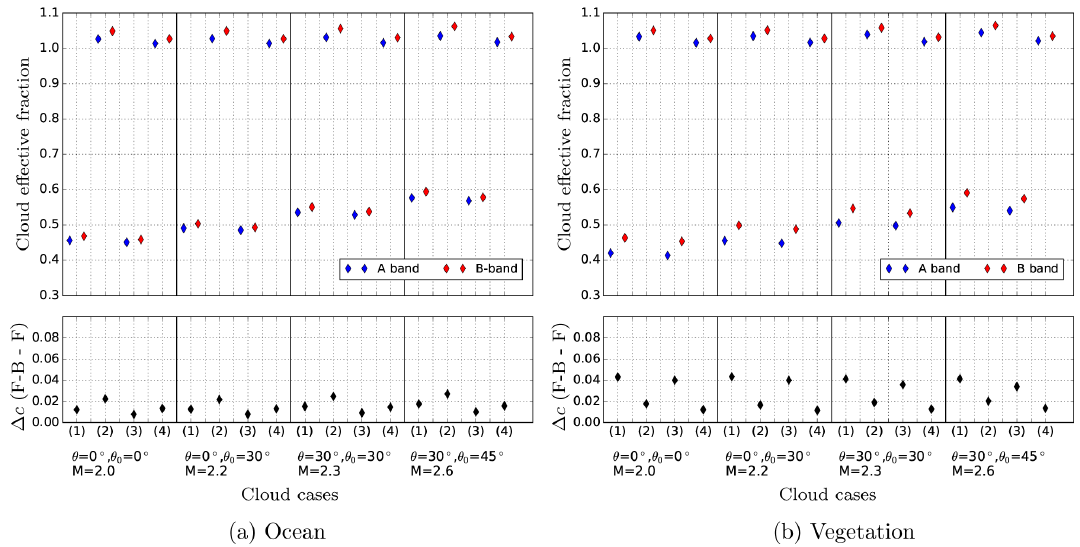
Figure 5. FRESCO-B (F-B) and FRESCO (F) effective cloud fraction retrievals (top panels) and effective cloud fraction differences (bottom panels) for the simulated cloud scenes over ocean (a) and vegetation (b) . The cloud cases are described in Table 1. The simulations have been made with an azimuth angle difference of 90 ◦ .